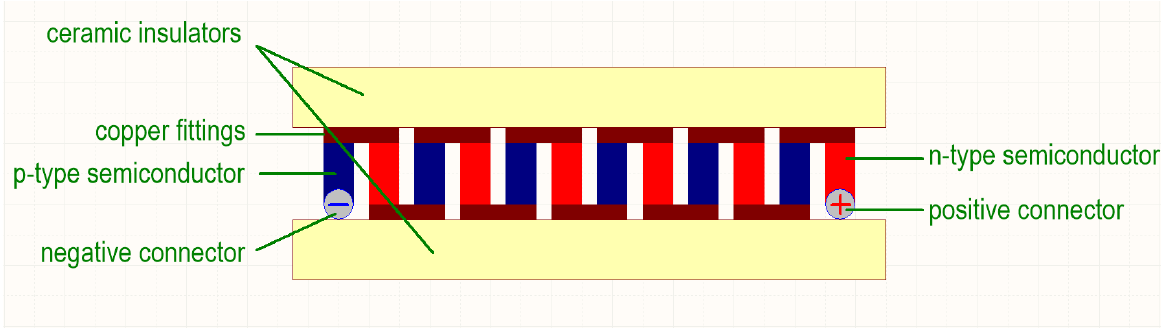
Figure 10. Construction of the Peltier cell.